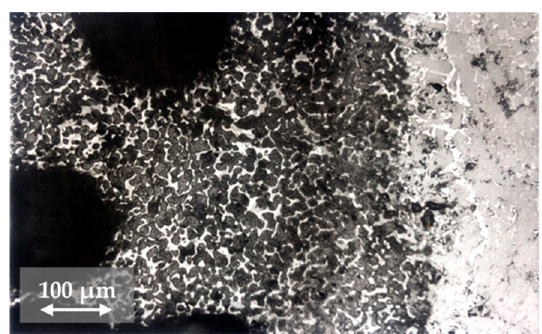
Figure 2. A lime part in the glassy silicate slag after 2.5 min of oxygen blowing, in the melting process D, sample D2.5. D, sample D2.5.